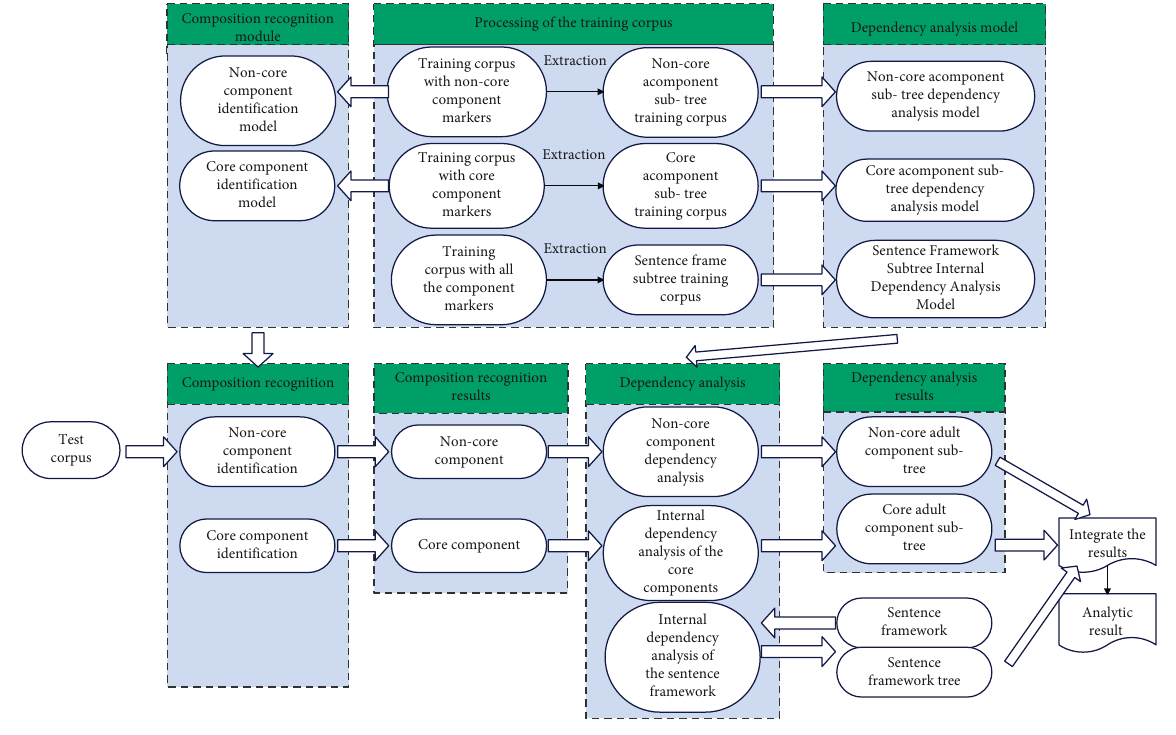
Figure 8: Test process diagram.